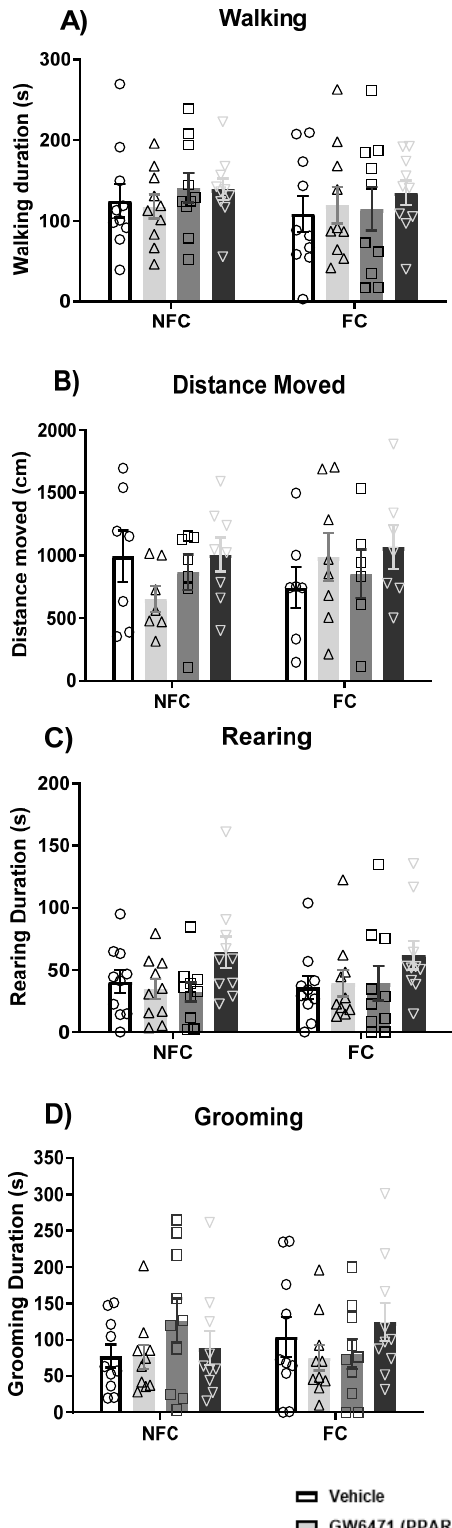
Figure 12. Effects of fear-conditioning and intra-BLA administration of selective PPAR α , PPAR β / δ , and PPAR γ antagonists on walking duration ( A ), distance moved ( B ), rearing duration ( C ), and grooming duration ( D ). Data are expressed as mean ± S.E.M.), each symbol represents one individual, ( n = 7–9 rats per group).